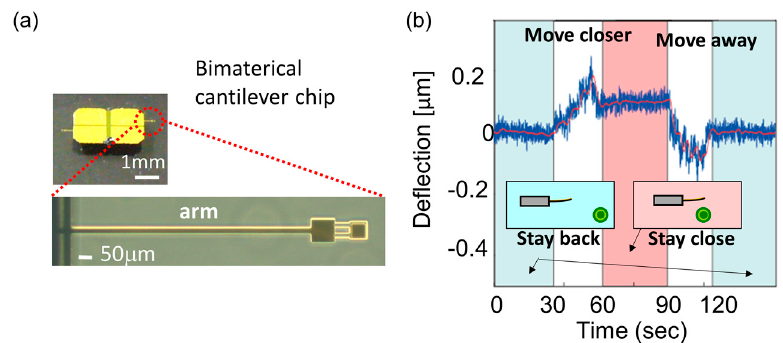
Figure 3. ( a ) Optical images of the completed chip with cantilever sensors; ( b ) Bimaterial microcantilever displacement versus time. Temperature change of the BFCs after adding NE; with the BFCs staying close to the sensor or the BFCs moving away, adopted from